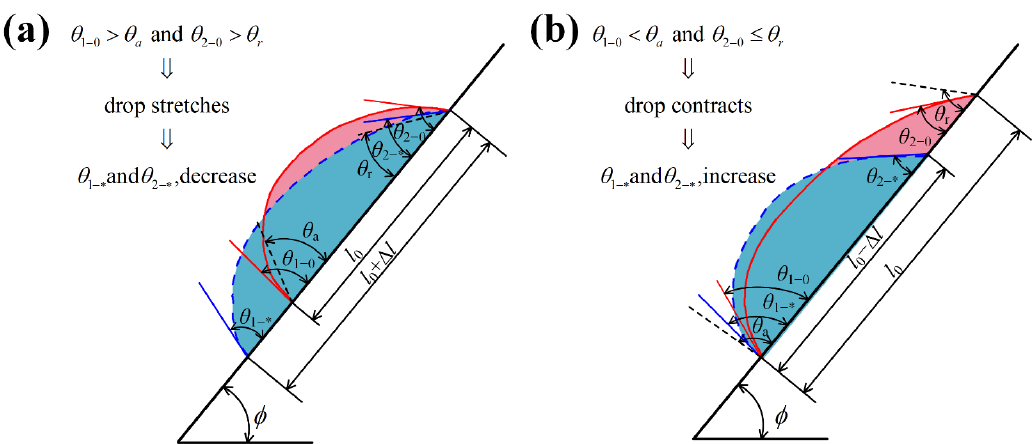
Figure 5. The changes of θ 1 −∗ and θ 2 −∗ in droplet evolution process. ( a ) θ 1 − 0 ≥ θ a and θ 2 − 0 > θ r : the drop stretches, and θ 1 −∗ and θ 2 −∗ both decrease. ( b ) θ 1 − 0 < θ a and θ 2 − 0 ≤ θ r : the drop contracts, and θ 1 −∗ and θ 2 −∗ both